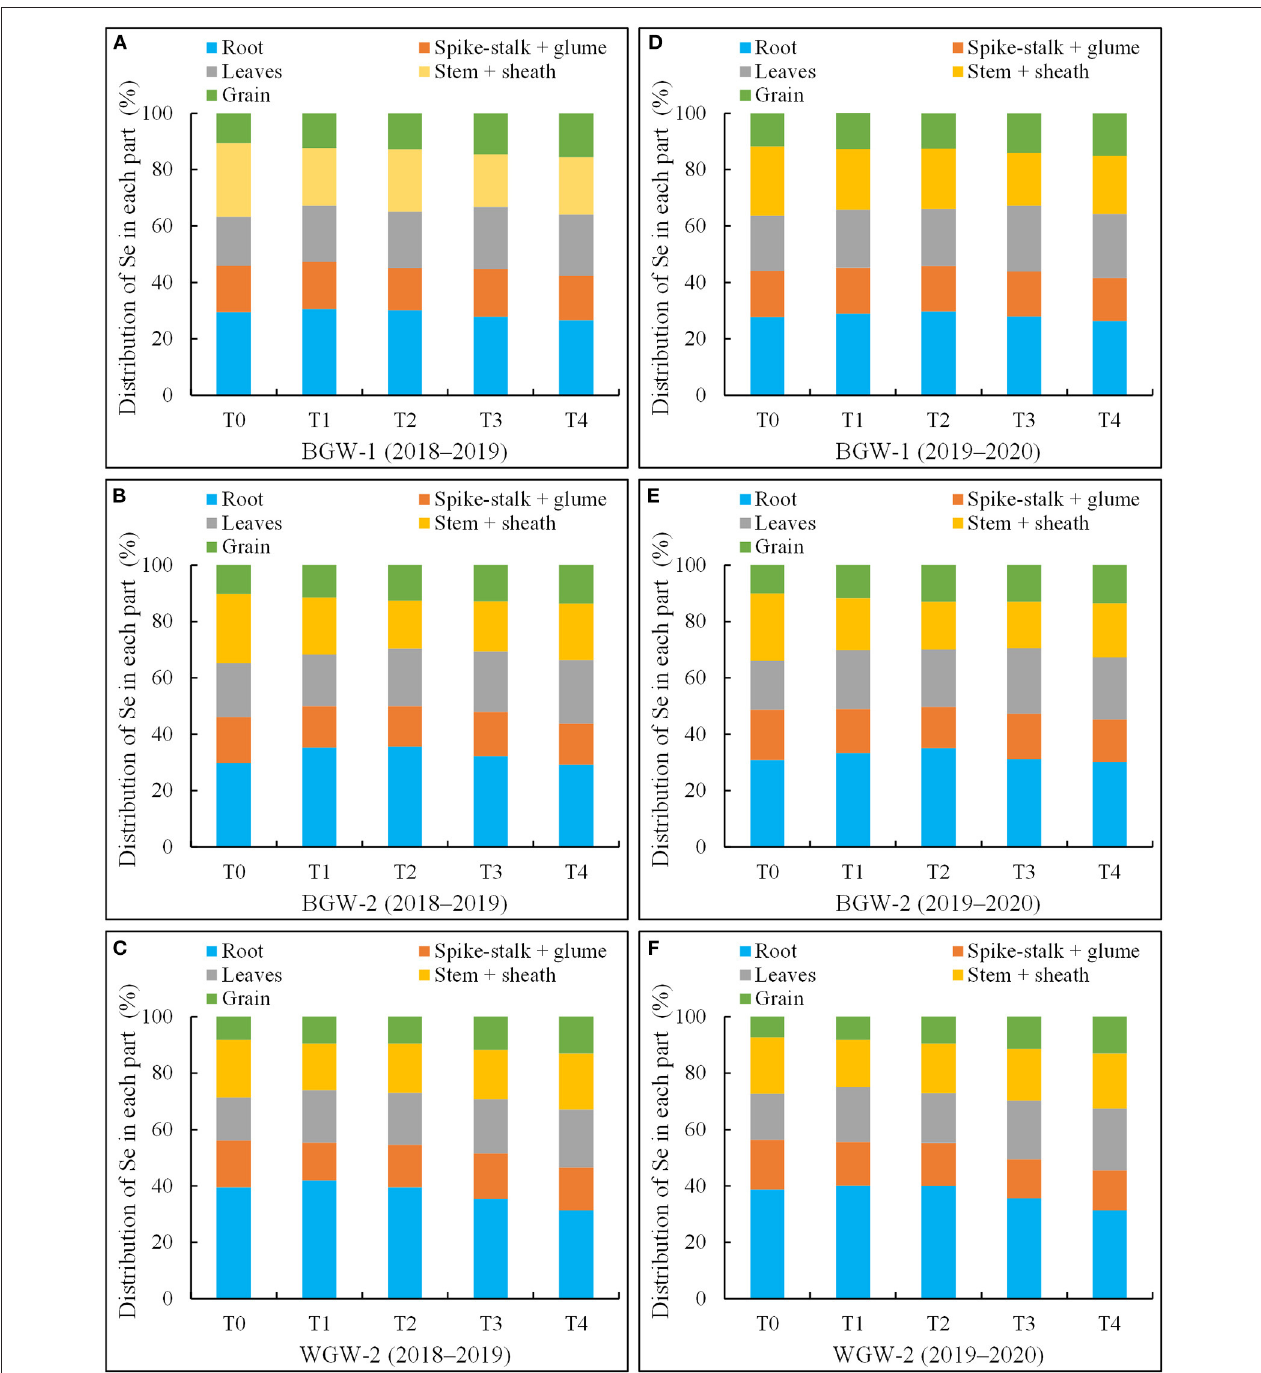
FIGURE 2 | The percentages of selenium (Se) in roots, spike-stalk + glum, leaves, stem + sheath, and grains compared to that of total Se in black-grained wheat (BGW) (BGW-1 and BGW-2) and white-grained wheat (WGW) (WGW-2) genotypes in the two growing seasons. Se distribution in each part represents the proportion in the total Se taken up by the whole plant. T0, no Se fertilizer; T1, 1,080 g · ha − 1 pure Se; T2, 2,160 g · ha − 1 pure Se; T3, 3,240 g · ha − 1 pure Se; T4, 4,320 g · ha − 1 pure Se; BGW-1, BGW genotype Xihei 88; BGW-2, BGW genotype Heidali; WGW-2, WGW cultivar Pubing 151. (A–F) , the distribution of Se in each plant of BGW-1 (2018–2019), BGW-2 (2018–2019), WGW-2 (2018–2019), BGW-1 (2019–2020), BGW-2 (2019–2020), and WGW-2 (2019–2020), respectively.